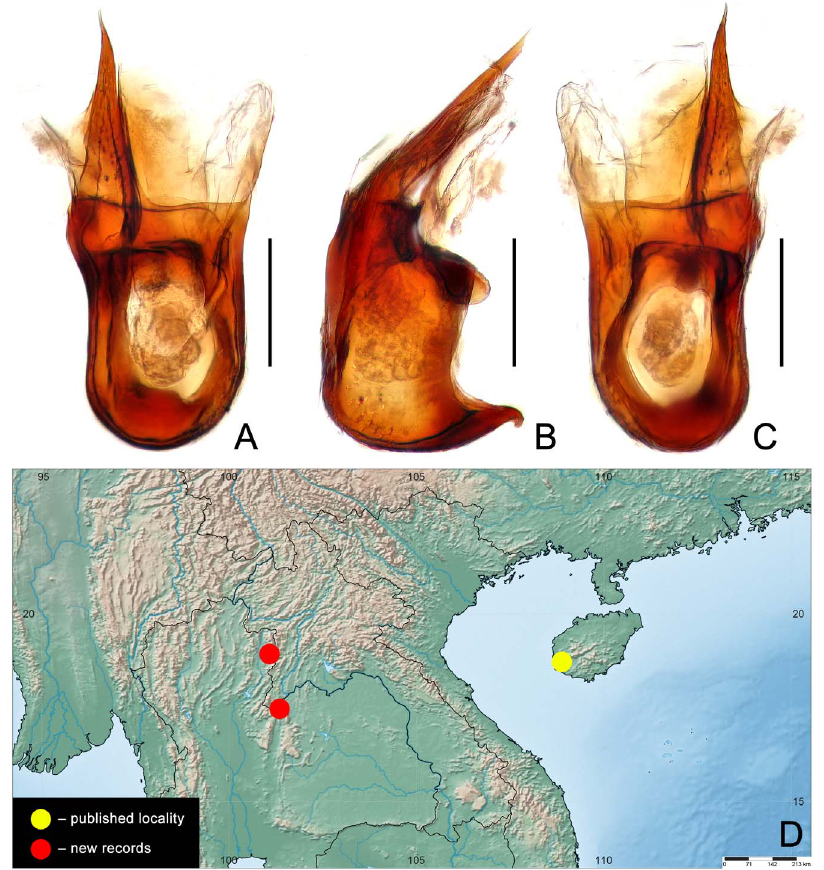
Figure 3. Aedeagus (A–C) and distribution (D) of Cerochusacilioceps in Thailand. (A) Dorsal view. (B) Lateral view. (C) Ventral view. Scales: 0.1 mm.